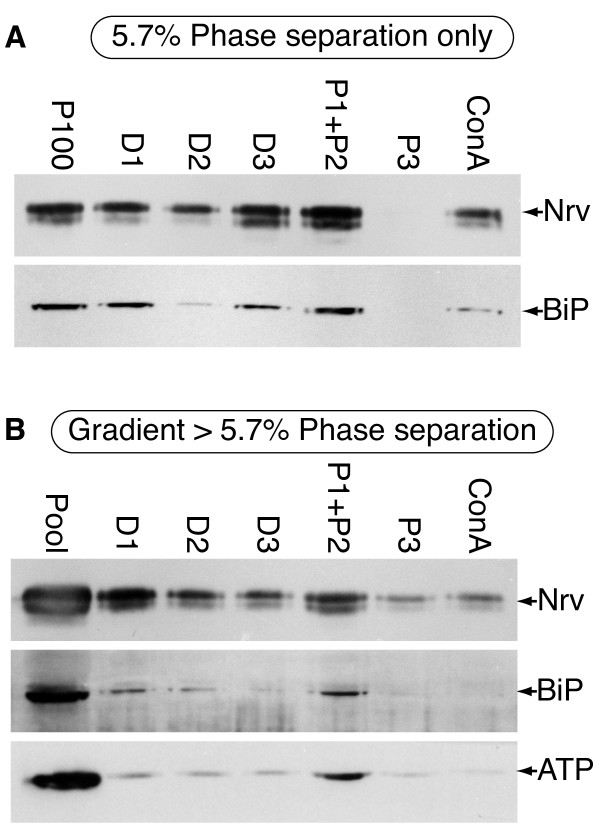
Immunoblot analysis of head microsomes fractionated by two phase affinity partitioning alone or by density gradient centrifugation followed by two phase affinity partitioning at 5.7% PEG/Dextran. A - Fractionation by two-phase affinity partitioning alone. The yield of Nervana is significantly improved (compare to Figure 4A.) However, BiP is still present in the ConA fraction indicating that 2PAP alone at the 5.7% concentration is still insufficient to produce high purity PM. Labeling: same as figure 2. Loading: All samples have equivalent loading, except P100, which was 1/5th of the others. B - Fractionation by two phase affinity partitioning following an initial density gradient fractionation. The Nervana is still found in the ConA sample, but this fraction no longer contains detectable BiP. Small amounts of residual ATP synthase are still present. Labeling: same as figure 4. Loading: Equivalent amounts of all fractions were loaded.